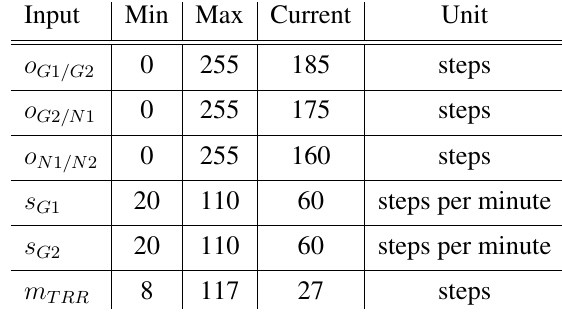
Figure 2: Load-follow transient considered (6-18) Table 1: List of all